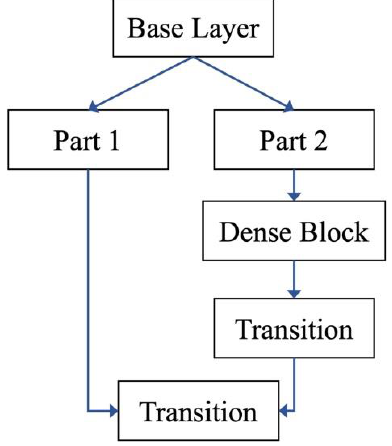
Figure 5. CSP DenseNet.